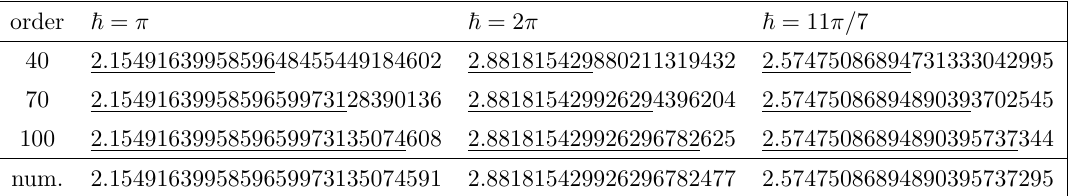
Table 3 . The Borel-Pad(cid:19)e sums of the perturbative ground state energy E (0) of the local F 0 with m 1 = 1 with various orders of truncation, compared with the stable numerical results. Underlined are the digits of the Borel-Pad(cid:19)e sums which are identical with the numerical